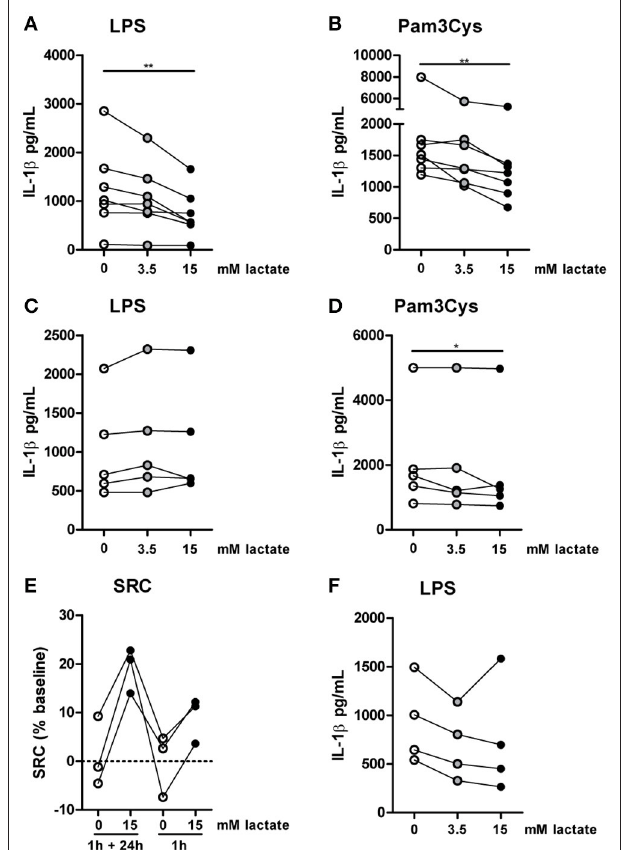
FIGURE 9 | Anti-inflammatory effects of lactate are time-dependent. Cytokine production of monocytes from healthy individuals. (A,B) Monocytes were pretreated with lactate for 1h before LPS (A) or Pam3Cys (B) was added for 24h. (C,D) Monocytes were pretreated with lactate for 1h, lactate was removed and cells were washed once before LPS (C) or Pam3Cys (D) was added for 24h. (E) Monocytes were treated as described for (A) or (C) before metabolism was measured. (F) Monocytes were stimulated with LPS. 4h after stimulation, lactate was added. (A,B) n = 7, (C,D) n = 5, (E) n = 3, (F) n = 4. * p < 0.05, ** p < 0.01, Friedman test with post-hoc Dunn’s